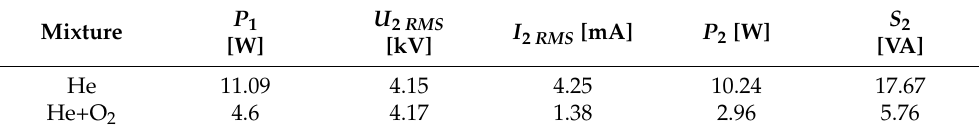
Table 3. Electrical parameters of the reactor for used gas mixtures.